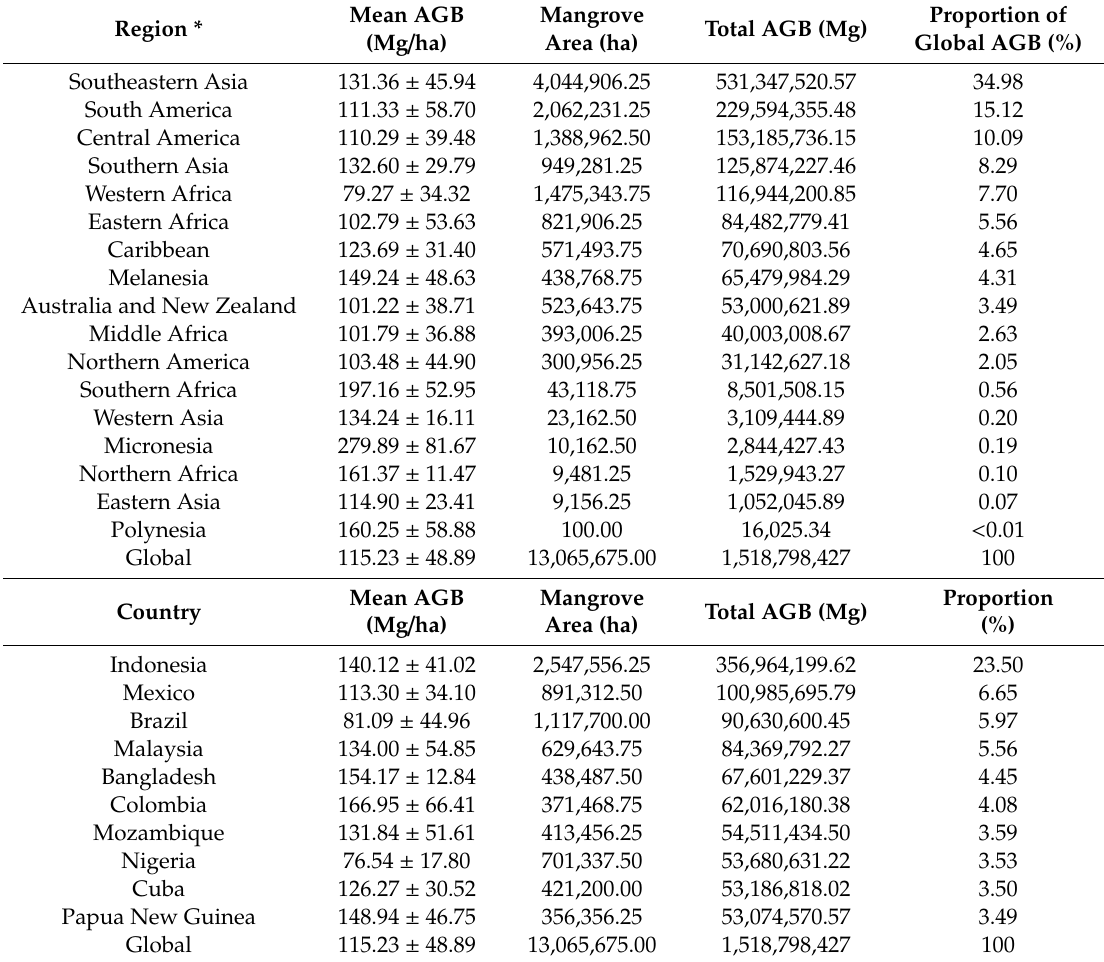
Table 2. The mean AGB density and total AGB in the di ff erent regions and